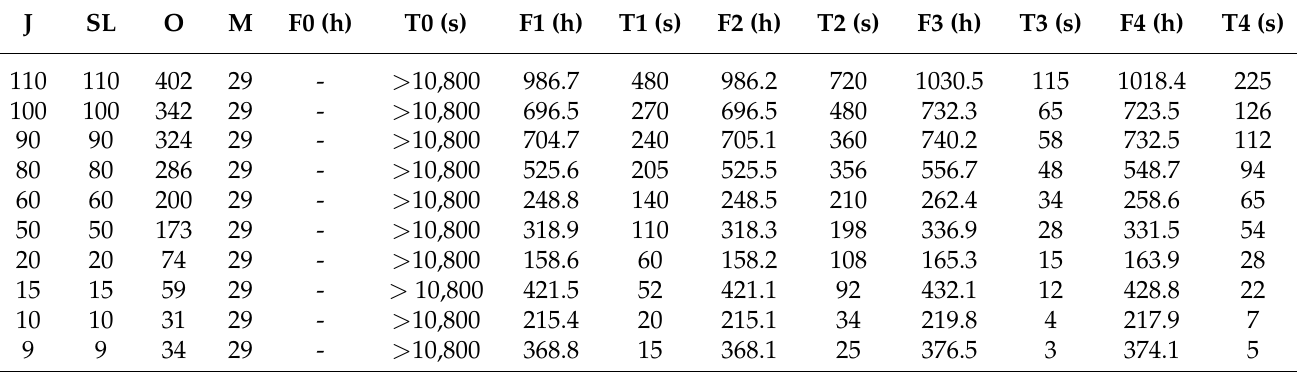
Table 6. Computational results of the developed resolution methods for randomly generated instances of the HCT type. J